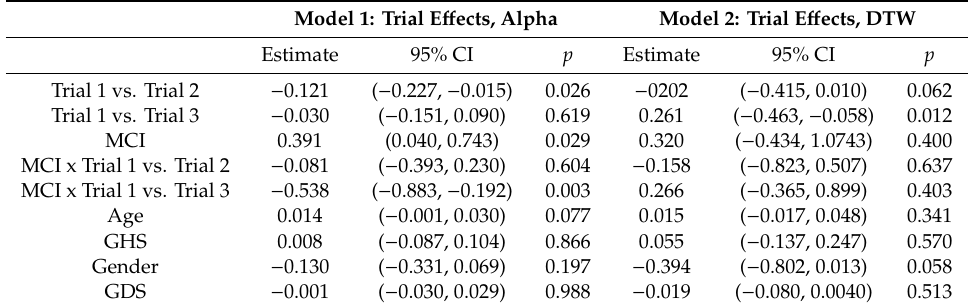
Table 4. Linear-Mixed-Model Estimates of Trial E ff ects on Rate of Error Letter Generation in Alpha and